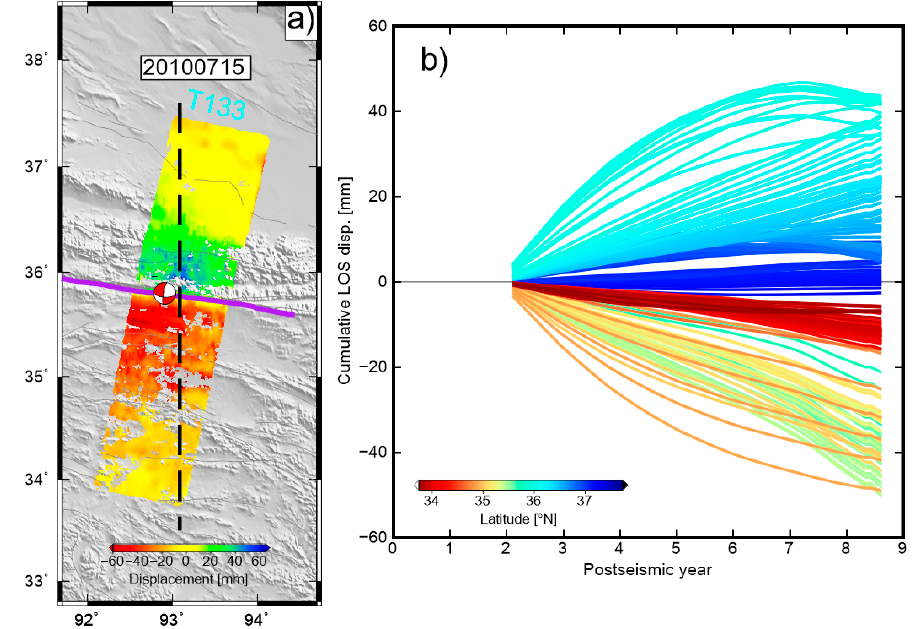
Figure 16. ( a ) Snapshot of the line of sight (LOS) InSAR timeseries on track 133 at acquisition date 15 July 2010 relative to 30 October 2003. The 2001 ruptures, the active faults and the focal mechanism are as in Figure 1b. The black dashed line shows the location of the north-south profile shown on panel b; ( b ) Range change time series showing varying cumulative displacements in near- and far-field. The color of each curve is based on its latitude.